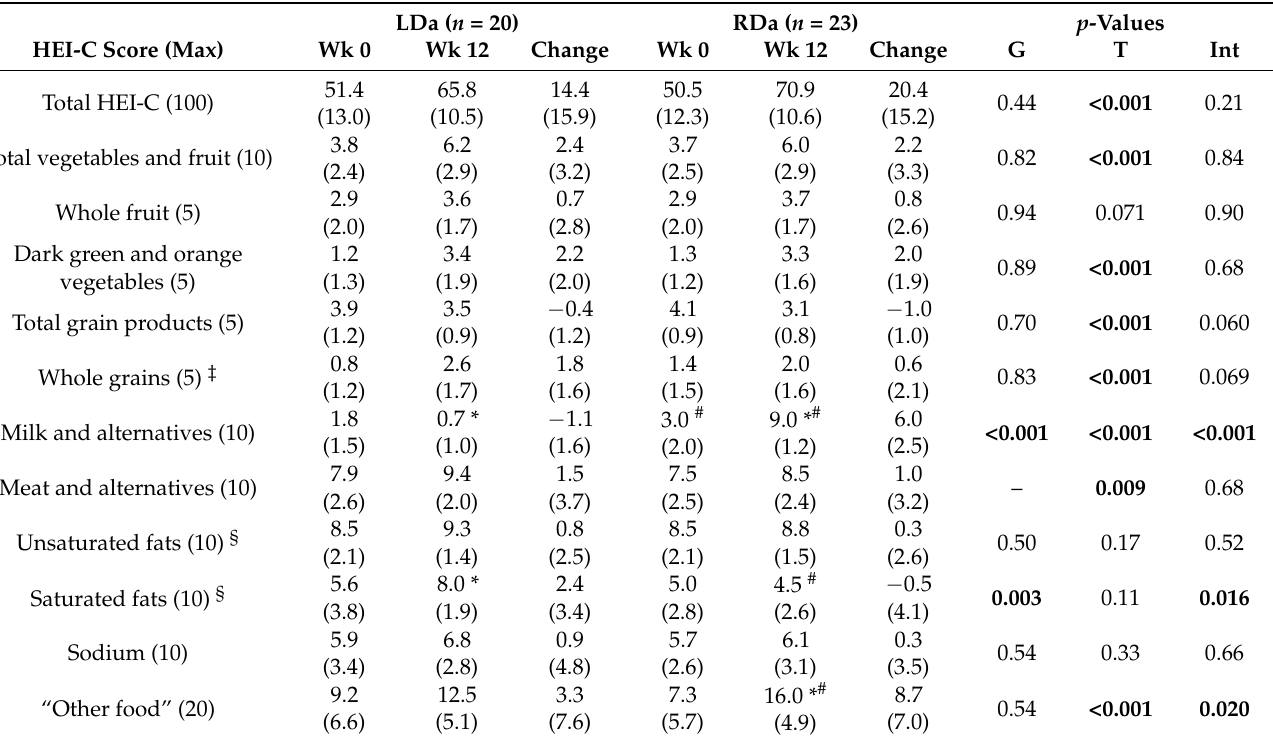
phosphorus. Relatedly, the proportion of RDa and LDa participants with a mean intake below the RDA was 39% and 100%, respectively, for calcium; 4% and 50%, respectively, for vitamin B12; and 22% and 90%, respectively, for phosphorus. Table 3. Canadian Healthy Eating Index (HEI-C) scores in adolescent females with over- weight/obesity in the low dairy product intake (LDa) and recommended dairy product intake (RDa) groups at weeks 0 and 12 of the intervention. LDa ( n = 20) RDa ( n = 23) p -Values